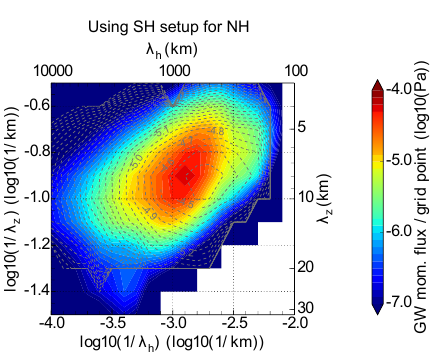
Figure A4. Filtered simulated GWMF spectra for Northern Hemi- sphere (July) 2006, run by using the set of scales selected for South- ern Hemisphere (January